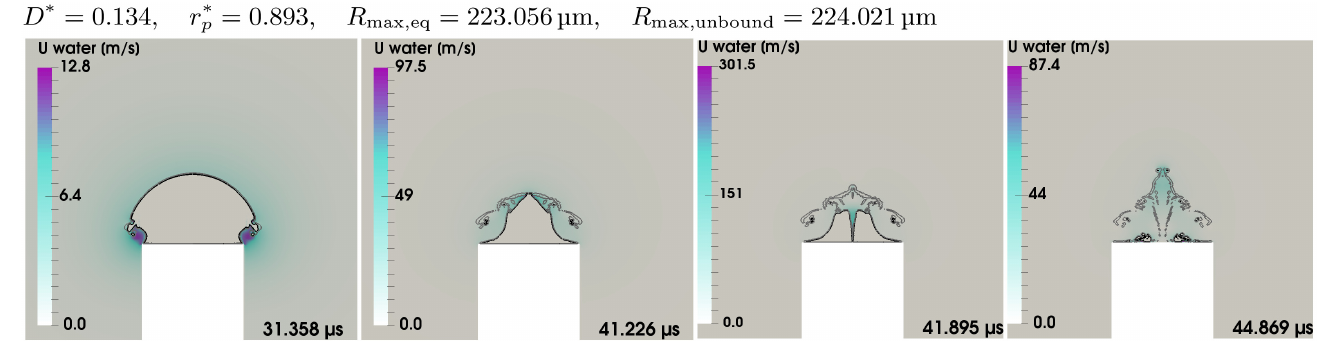
Figure 18. Mushroom bubbles with the magnitude of the flow velocity of the liquid. Bubbles at the same r ∗ p = 0.423 for two further normalized distances D ∗ with the same R max,unbound , in addition to Figure 17. Cylinder radius is 200µm.